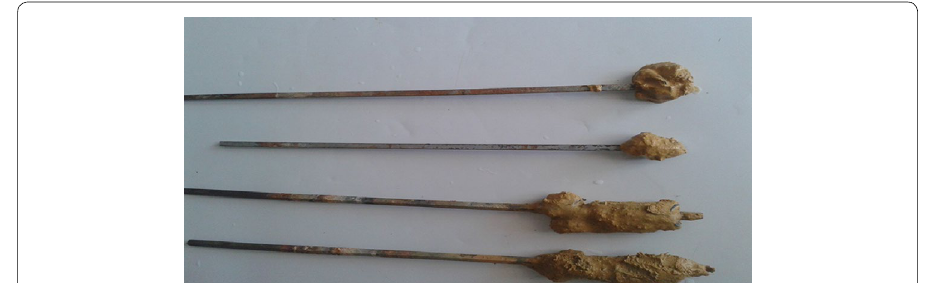
Fig. 19 Failure modes types of helical piles in expansive soil